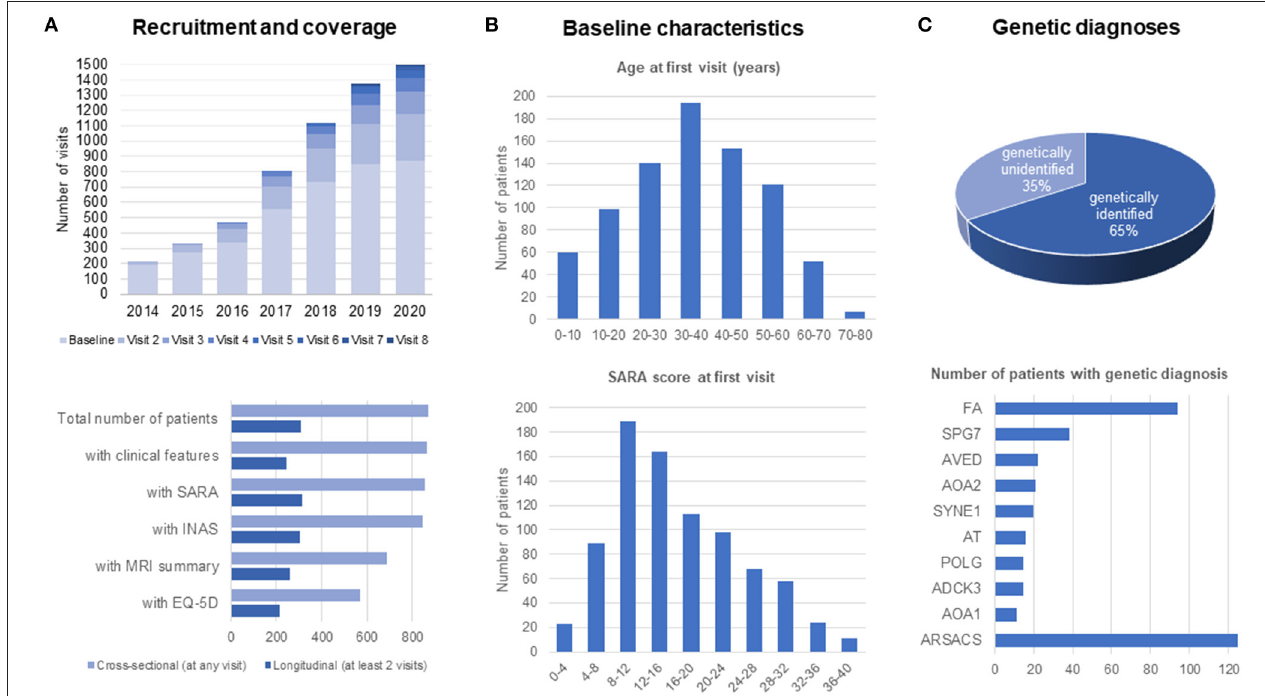
FIGURE 3 | Recruitment and patient characteristics in the ARCA Registry. (A) Recruitment and coverage. Recruitment of patients is continuous since 2013, reaching more than 800 patients with up to eight longitudinal assessments by the end of 2020. Longitudinal data with at least two assessments are available in about 200–300 patients. (B) Baseline characteristics of patients. Patients in the ARCA Registry span the full range of ages and disease stages. (C) Genetic diagnoses in the ARCA Registry, with a list of the 10 most frequent genetic